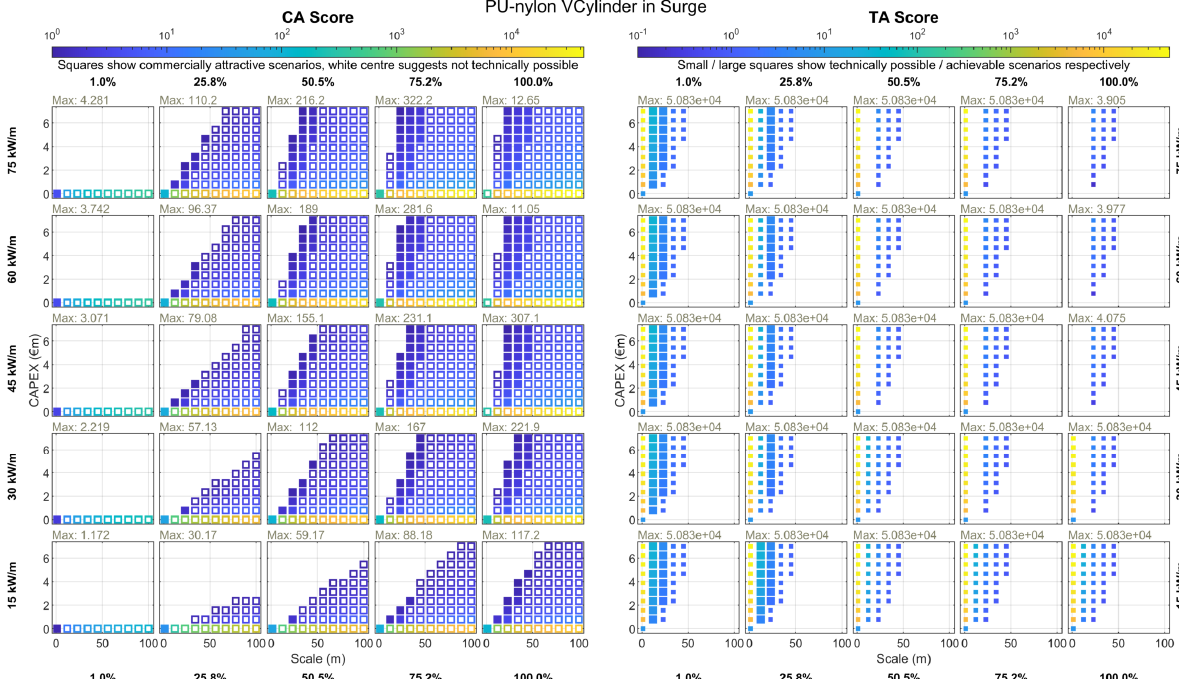
Figure 11. Graphical visualisation of the results for one combination of material, shape, and degree-of-freedom. Left 25 plots show commercially attractive scenarios with a logarithmic colour scale of CA Score. Right 25 plots show scenarios deemed technically possible (small squares) and technically achievable (large squares) with a different logarithmic colour scale of TA Score. Scenarios not technically possible are shown with white centre on left plots and omitted from right plots. The outer axis of rows of plots correspond to varying resource (KW/m), columns to varying efficiency (%), with individual (inner) plot axes of scale (m) and CAPEX (€m). Maximum technically possible score quoted above each plot. See text for discussion.